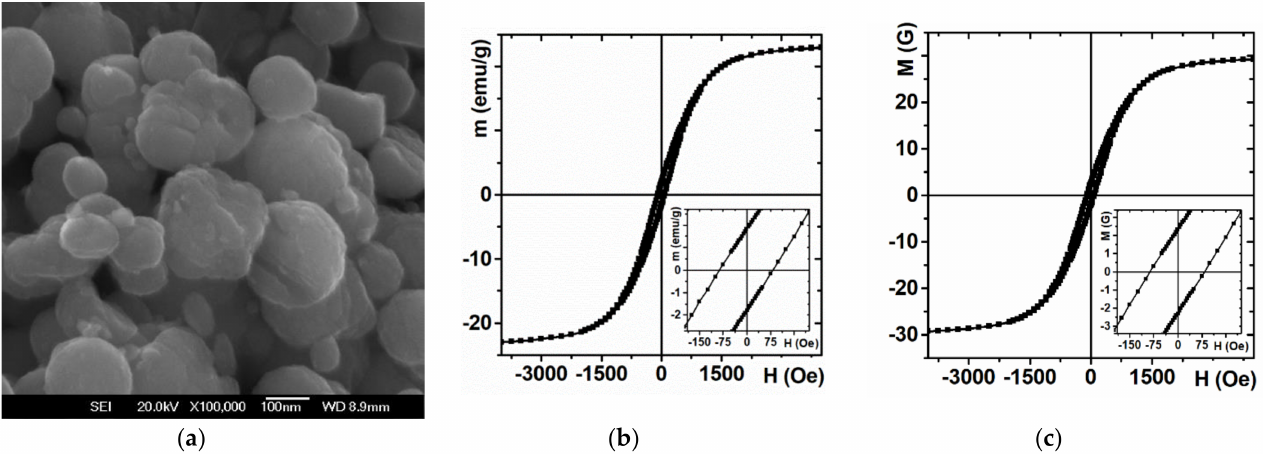
Figure 4. General view of magnetic particles used as a filler for fabrication of the epoxy composites—SEM ( a ). Magnetic properties of the magnetic composite: ( b ) specific magnetic moment; ( c )